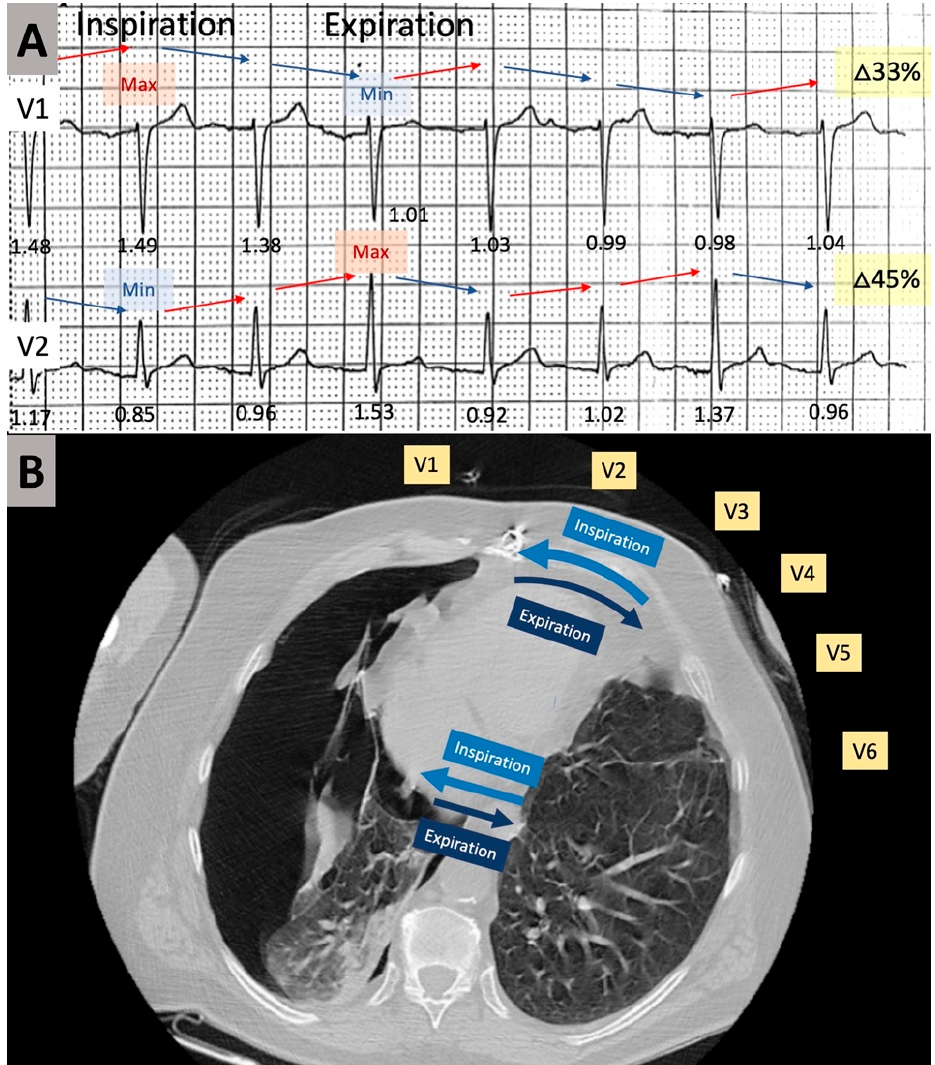
Figure 6. Possible mechanism for the phasic changes in QRS complex voltage noted on lead V1 and V2 on the initial 12-lead electrocardiogram. QRS voltages expressed in millivolts are shown under each beat. Both direction and magnitude of change of the QRS voltage are displayed. Red arrows point to an increase in voltage, while blue arrows depict a decrease in voltage. The complex with maximum and minimum voltage is depicted with “Max” and “Min” labels, respectively. The magnitude of change measured as percent change between the complex with minimum voltage and maximum voltage is shown on the right side of the tracing on a yellow label ( A ); A mechanistic hypothesis that could explain the phasic QRS complex changes. As a consequence of the atelectatic right lung, during inspiration (light blue arrows), the expansion of the left lung displaces the heart towards the right, bringing the septum and apex of the heart more towards lead V1 with an increase in QRS amplitude. During expiration the heart moves in the opposite direction (dark blue arrows).